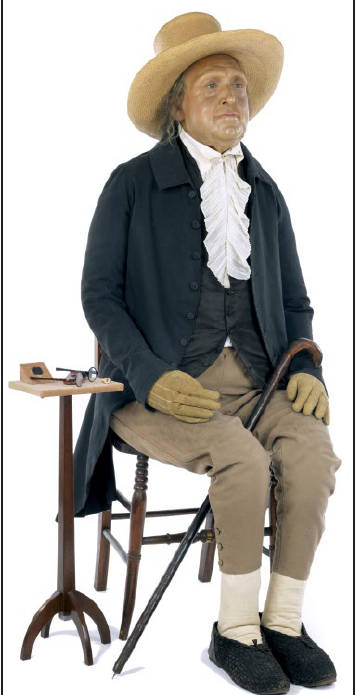
Figure 5: The Jeremy Bentham auto icon housed at UCL (Photo: UCL Digital